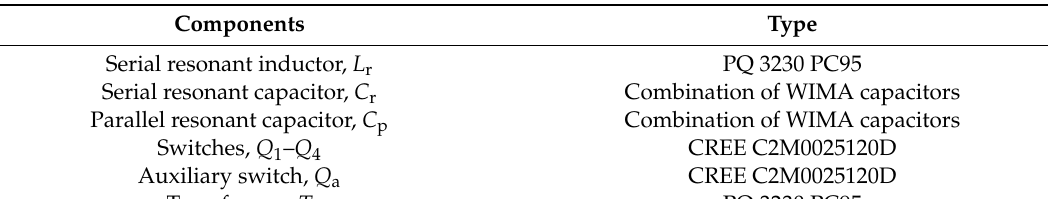
Figure 11. Photograph of the prototype built in the laboratory. Table 1. Main components of the proposed converter.